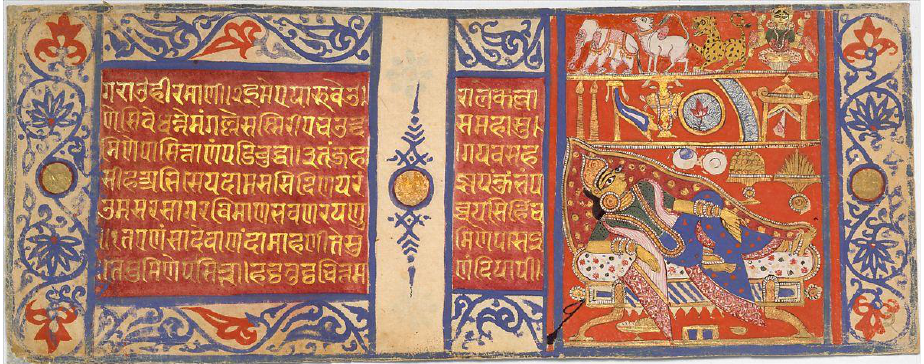
Figure 4. Devānandā’s dreams . Artist:Master of the Jaunpur Kalpasutra (Indian). Date: ca. 1465. Culture: India, (Gujarat, Jaunpur). Medium: Opaque watercolor on paper. Dimensions: Overall: 4 5/8 × 11 1/2 in. (11.8 × 29.2 cm). Classification: Paintings. Credit Line:Purchase, Cynthia Hazen Polsky Gift, 1992. Accession Number: 1992.359. Metropolitan Museum.